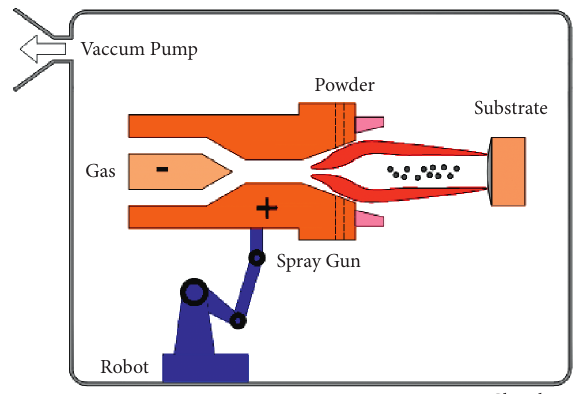
Figure 5: Schematic diagram of DC vacuum plasma spray system.